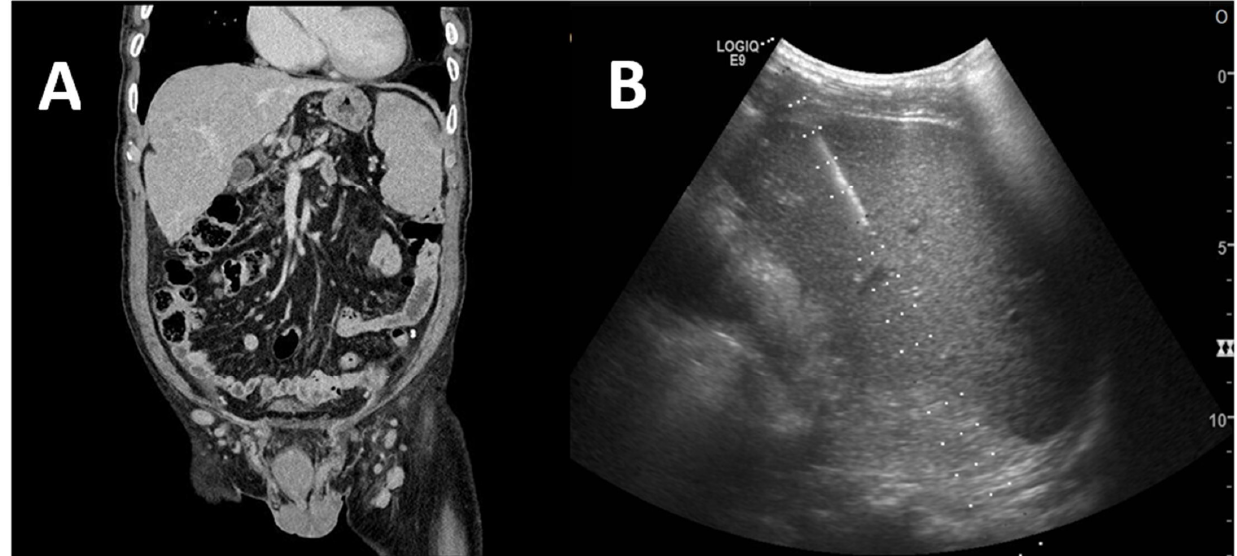
Figure 1. Imaging study on admission. ( A ) Contrast-enhanced computed tomography revealed hepatomegaly with cirrhosis-like surface of liver and splenomegaly with peripheral, wedge-shaped hypo-enhancing region, which indicates typical splenic infarction. ( B ) Percutaneous ultrasound- guided liver biopsy was performed.